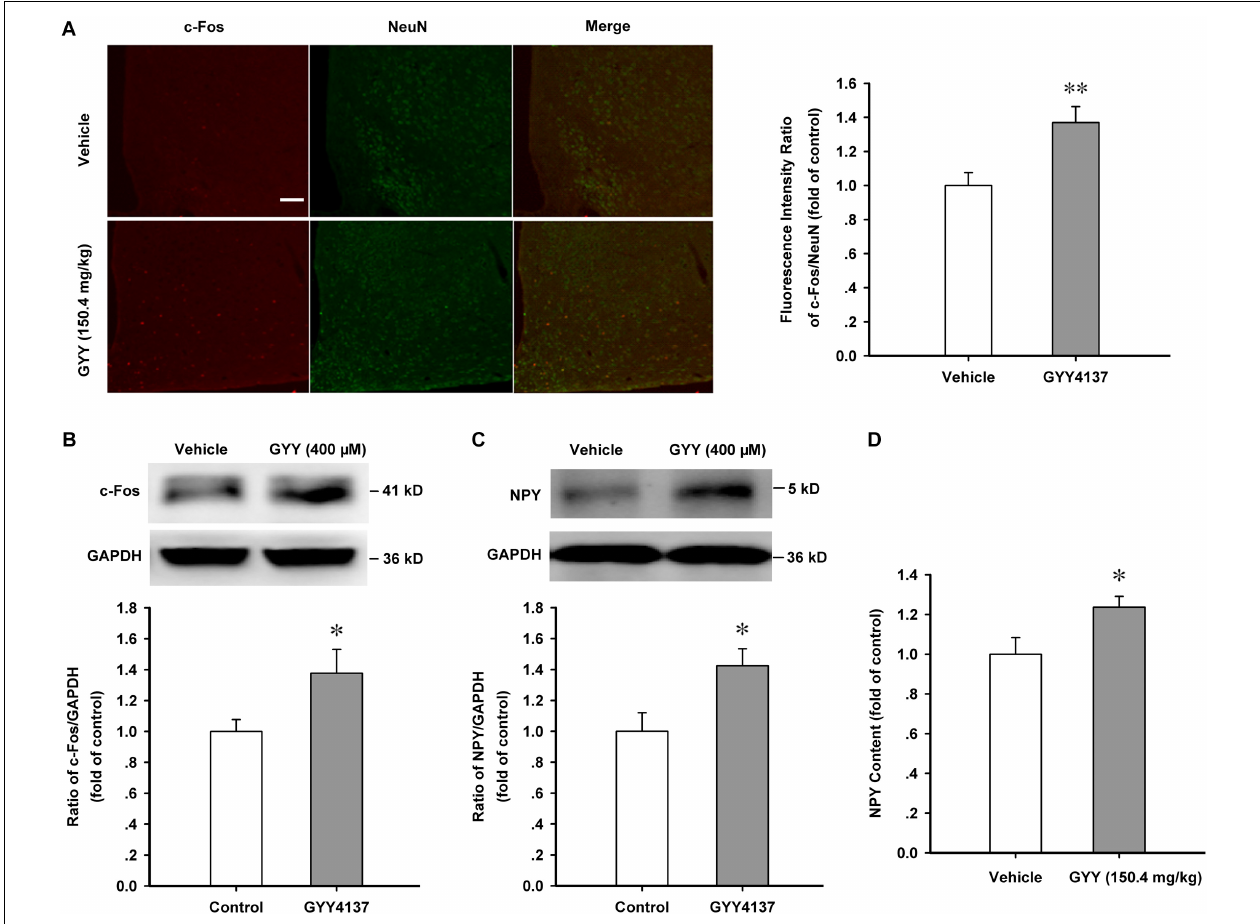
FIGURE 2 | GYY4137 promotes the activation of ARC neurons and increases NPY content. (A) Immunofluorescence result showing GYY4137 (150.4 mg/kg) treatment for 1 h increased the nuclear expression of c-Fos in hypothalamic ARC neurons (vehicle, n = 18; GYY4137, n = 29 cells). Scale bar, 200 µ m. (B) Western blot assay showing the increased expression of c-Fos protein after GYY4137 (150.4 mg/kg) treatment for 1 h in ARC tissue ( n = 5). (C) Western blot assay showing GYY4137 (150.4 mg/kg, 1 h) increased the expression of NPY in hypothalamic ARC tissue ( n = 4). (D) Statistical results showing GYY4137 (150.4 mg/kg, 1 h) increased the NPY content in ARC tissue of mice ( n = 6). Data are normalized as folds to control and expressed as means ± SEM. One-way ANOVA was used. ∗ P < 0.05, ∗∗ P < 0.01 vs vehicle.